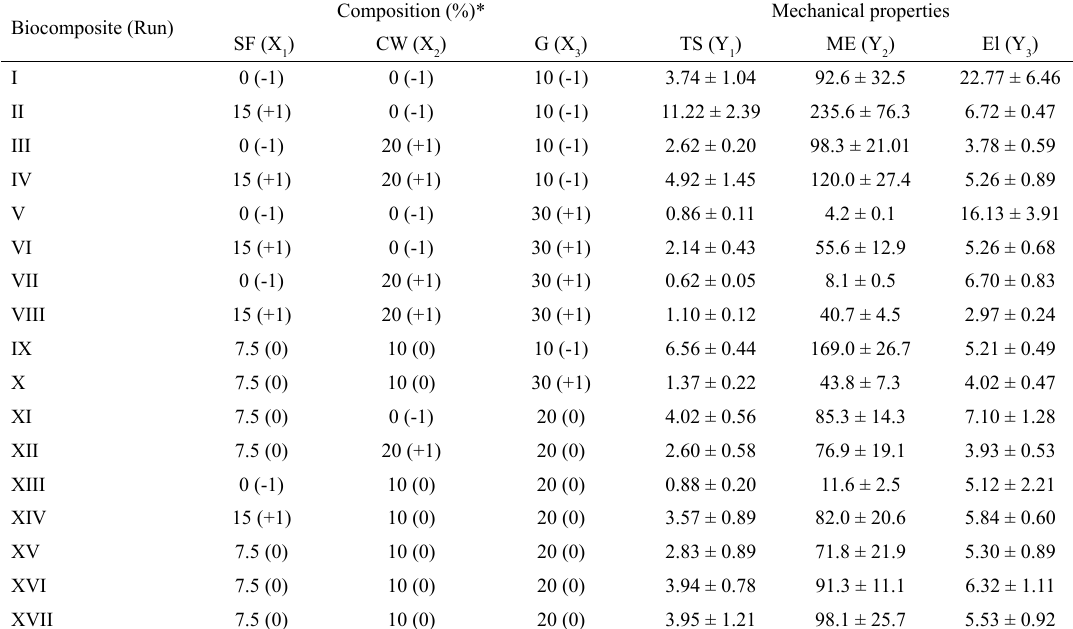
Table 3. Mean values and standard deviation of the tensile strength (TS), modulus of elasticity (ME) and elongation at Break (El) for biocomposites. Biocomposite